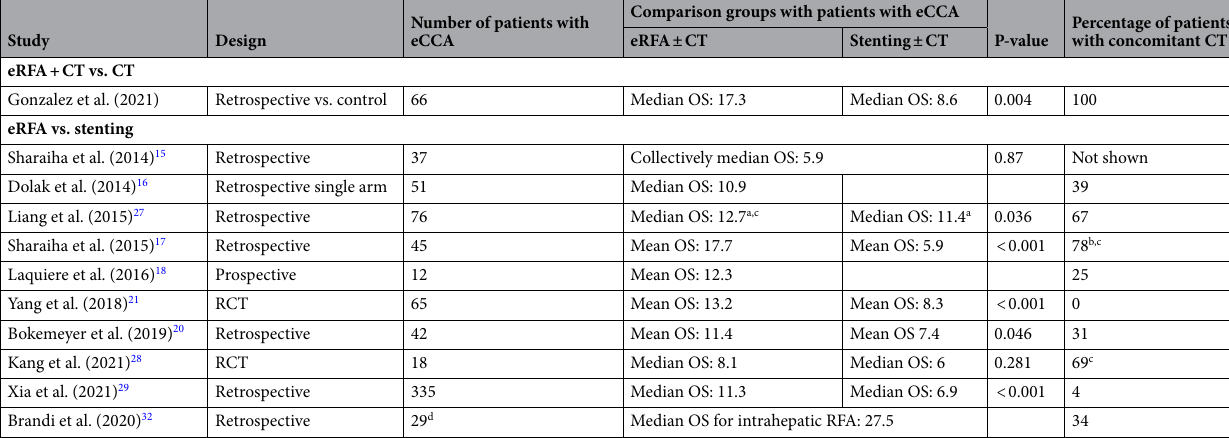
Table 5. Comparison of other publications on eRFA and CT in CCA. Overall survival is presented in months. P-values refer to log rank test. CCA cholangiocarcinoma, CT chemotherapy, eRFA endobiliary radiofrequency ablation, OS overall survival, RCT randomized controlled trial. a Visually estimated median OS based on Kaplan–Meier survival curve. b Only shown for eRFA-group. c Only shown for all tumor localizations included in the study. d Intrahepatic